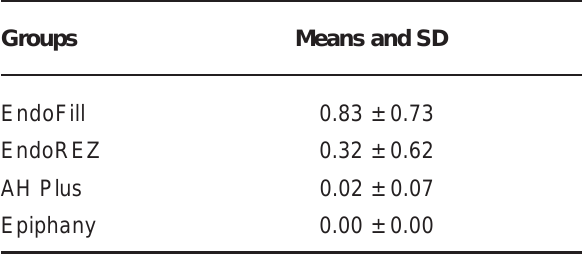
TABLE 1- Mean values and standard deviation of apical dye penetration for each root canal sealer, in millimeters